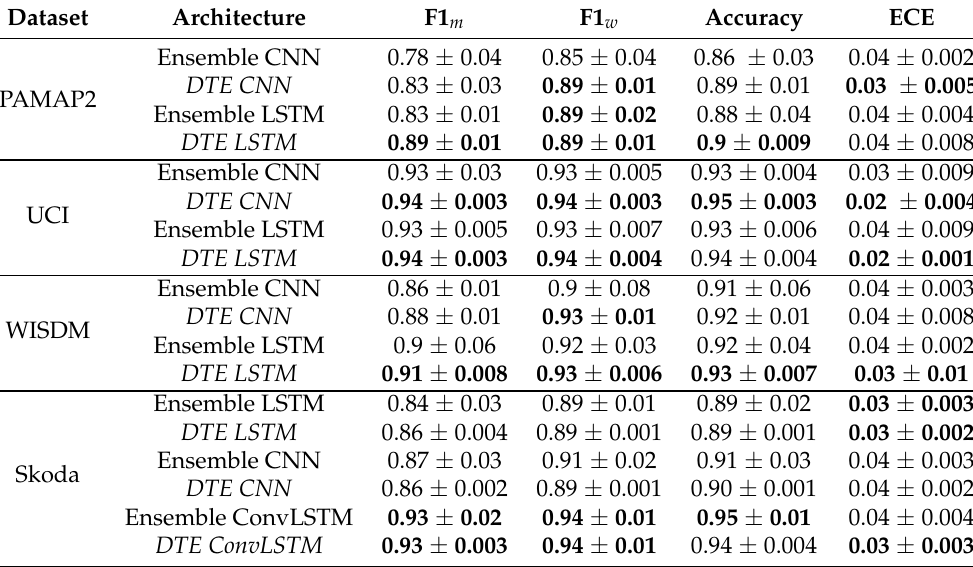
Table 4. Classification and calibration results (10 experiments per setting) for comparing standard ensemble versus DTE (our method) across all datasets and